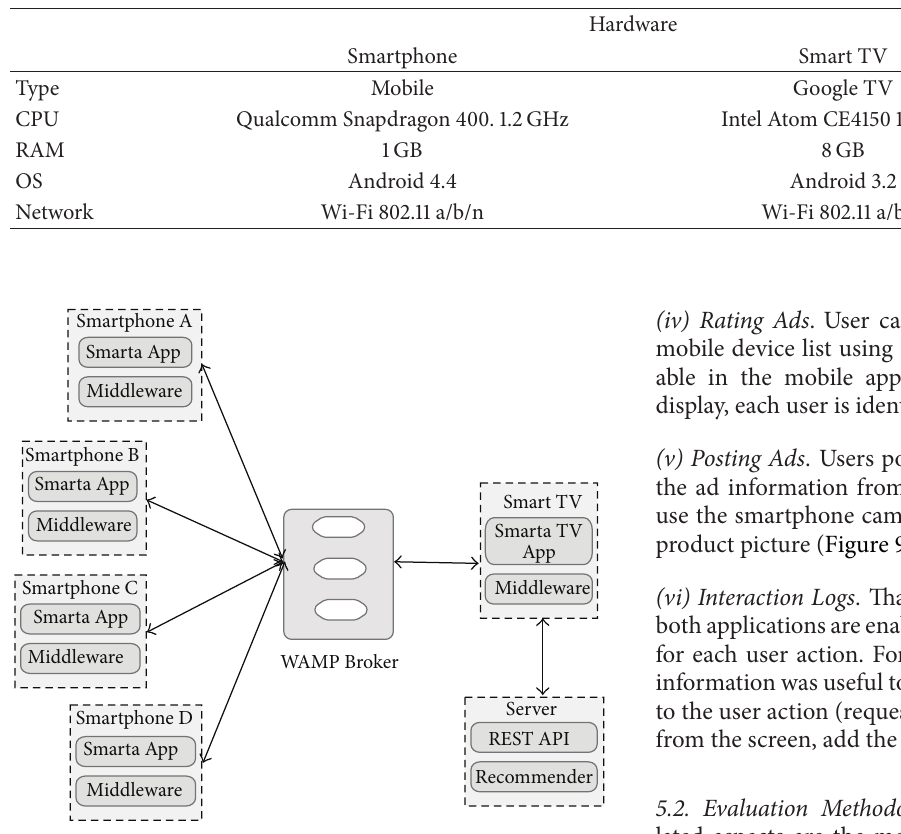
Figure 6: Prototype